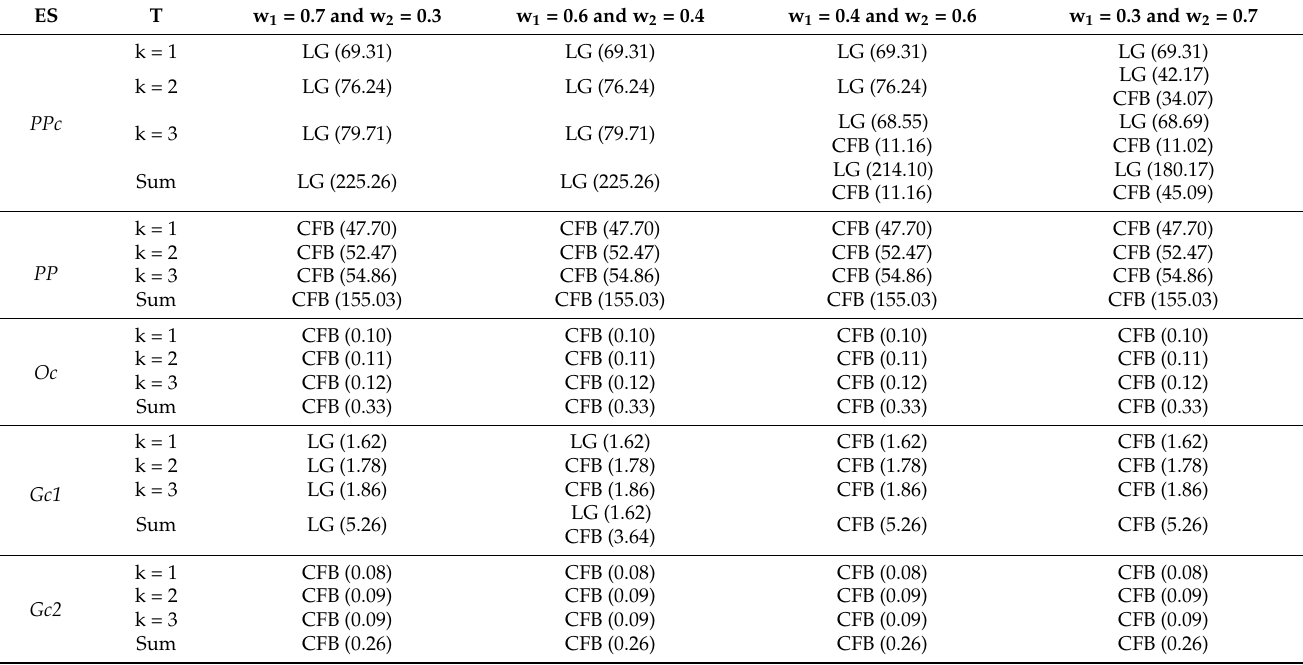
Table 5. The optimal treated SO 2 magnitude of various